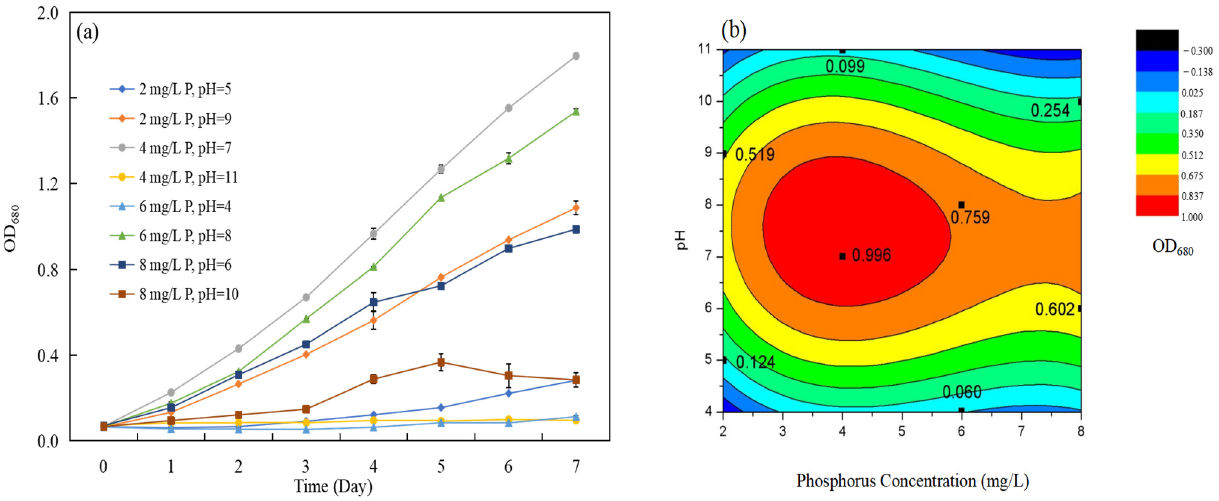
Figure 3. ( a ) The uniform design results under different phosphorus sources and pH of the effect on the growth of Scenedesmus dimorphus . ( b ) The contour line fitting diagram of the effect on the growth of Scenedesmus dimorphus ( n = 3).